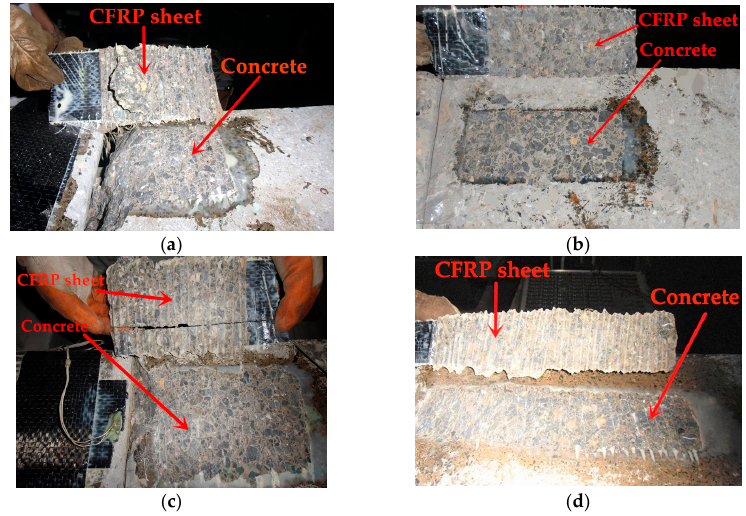
Figure 3. The failure modes of specimens: ( a ) C-02; ( b ) C-1; ( c ) C-2; and ( d ) D-1.